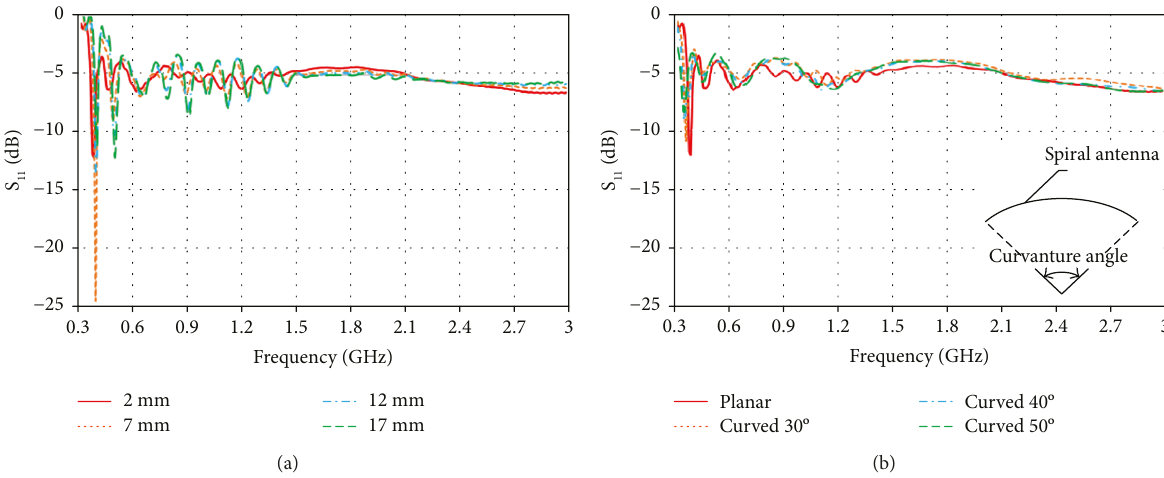
Figure 10: Simulated |S11| of the spiral antenna on the SAM phantom. (a) Planar spiral antenna at various distances from SAM phantom. (b) Di ff erent curvatures of the spiral antenna on the SAM phantom [60].